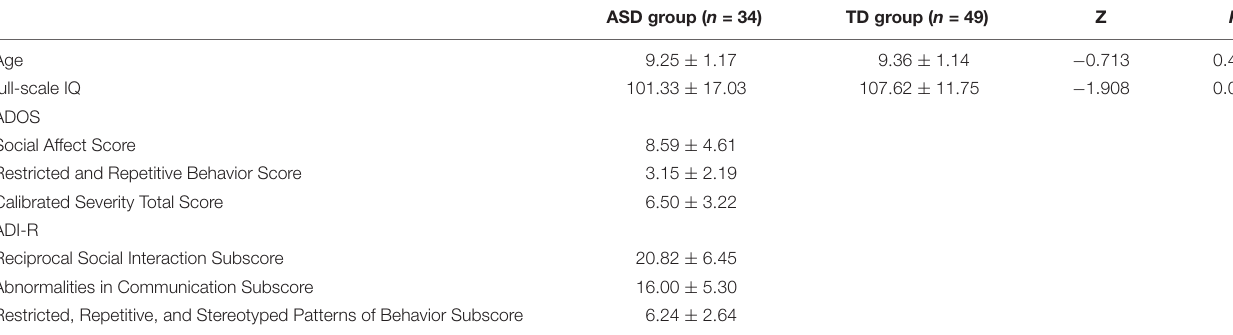
TABLE 1 | Demographic and clinical characteristics of boys with ASD and TD participant.